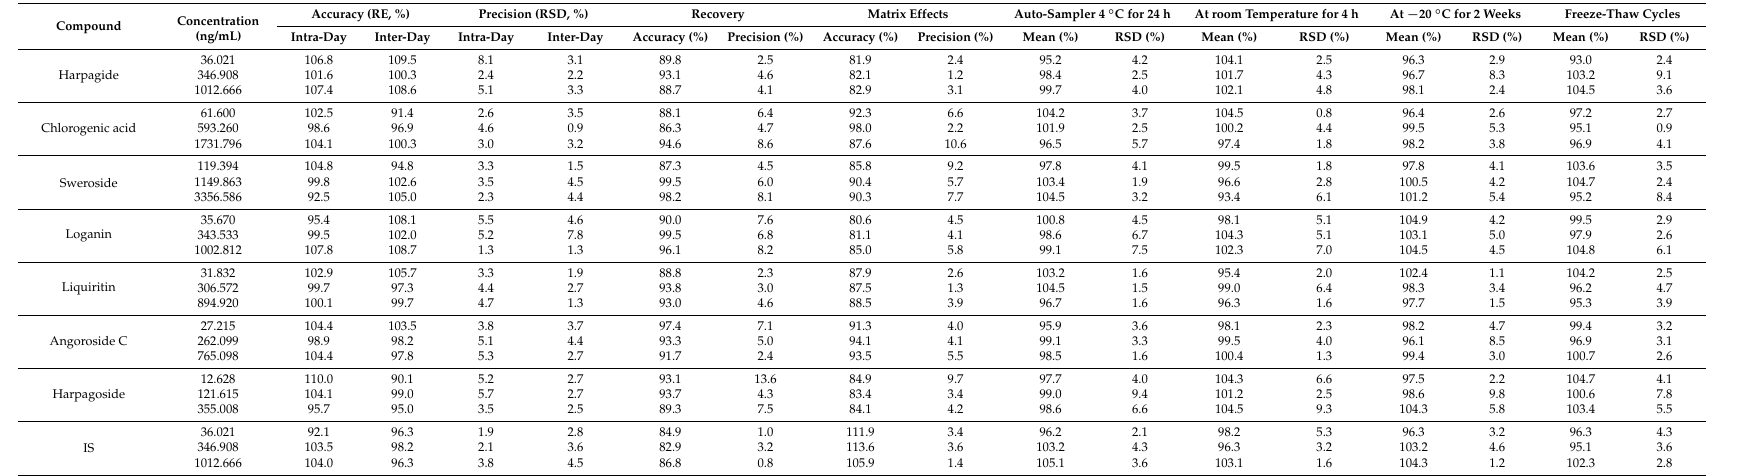
Table 2. The accuracy (intra- and inter- day), precision (intra- and inter- day), recovery, matrix effects and stability for 7 compounds in rat plasma ( n = 18, 6 replicates per day for 3